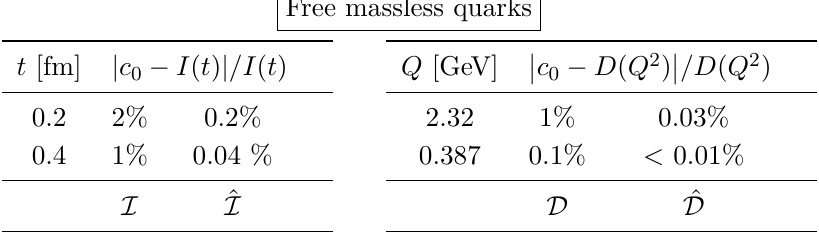
Table 3 . Accuracy of the continuum estimates obtained by fitting with the ansatz c 0 + c 2 a 2 the lattice observables I ( t ) , D ( Q 2 ) and their improved versions ˆ I ( t ) , ˆ D ( Q 2 ) defined in eqs. (3.15) and (3.16). The accuracy is expressed in terms of the relative difference with the known continuum values I ( t ) and D ( Q 2 ) . The lattice data and the fit curves are shown in figure